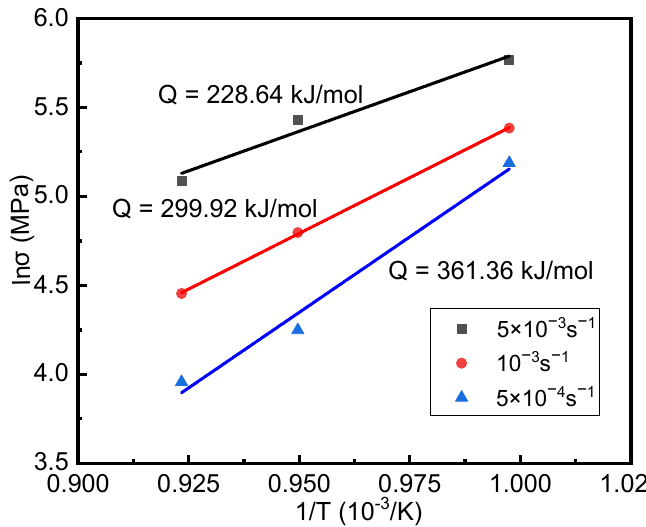
Figure 3. ln σ -1/T curve of Ti-6Al-4V alloy .